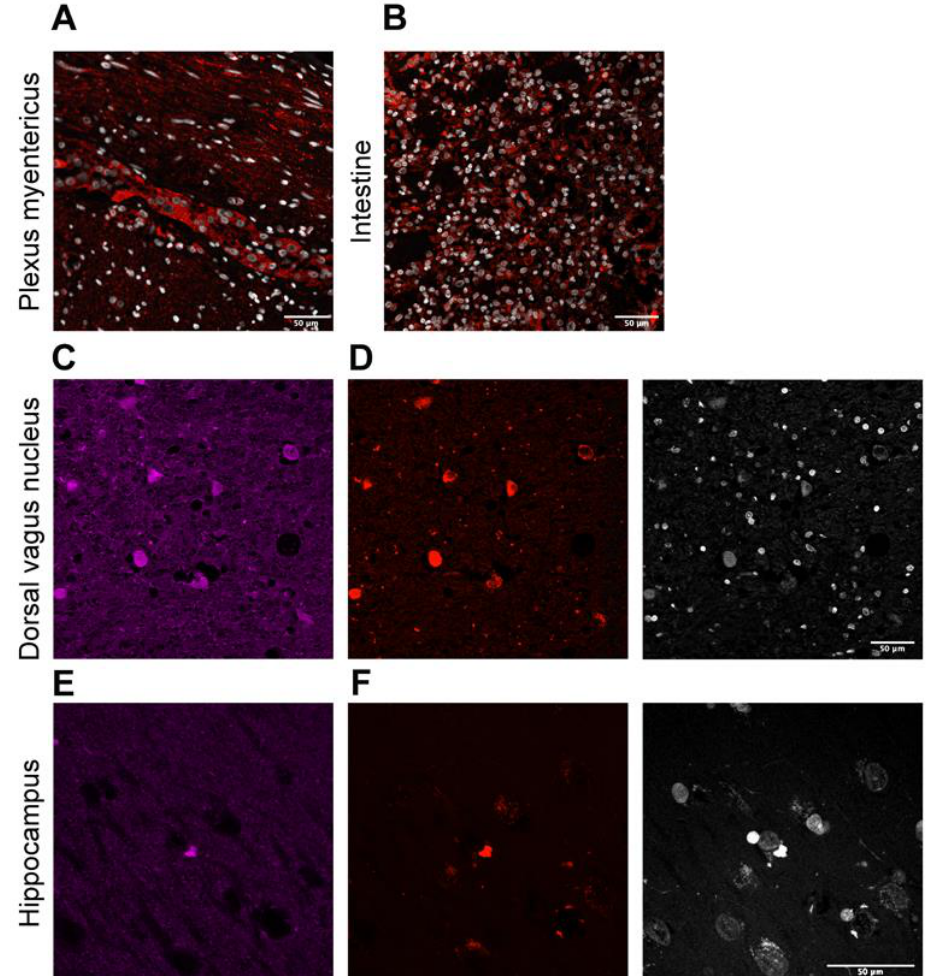
Figure 5. ( A , B ) Representative images of norovirus capsid protein VP1 immunofluorescence (red) counterstained with DAPI (blue) revealed abundant norovirus in the myenteric plexus ( A ) and the intestine ( B ). ( C – F ) Representative image of double immunofluorescence of VP1 (red) and alpha- synuclein (magenta) in different regions of the brain. There is colocalization in the dorsal vagus nucleus ( C , D ) and hippocampus ( E , F ). Scale bar: 50 µm.